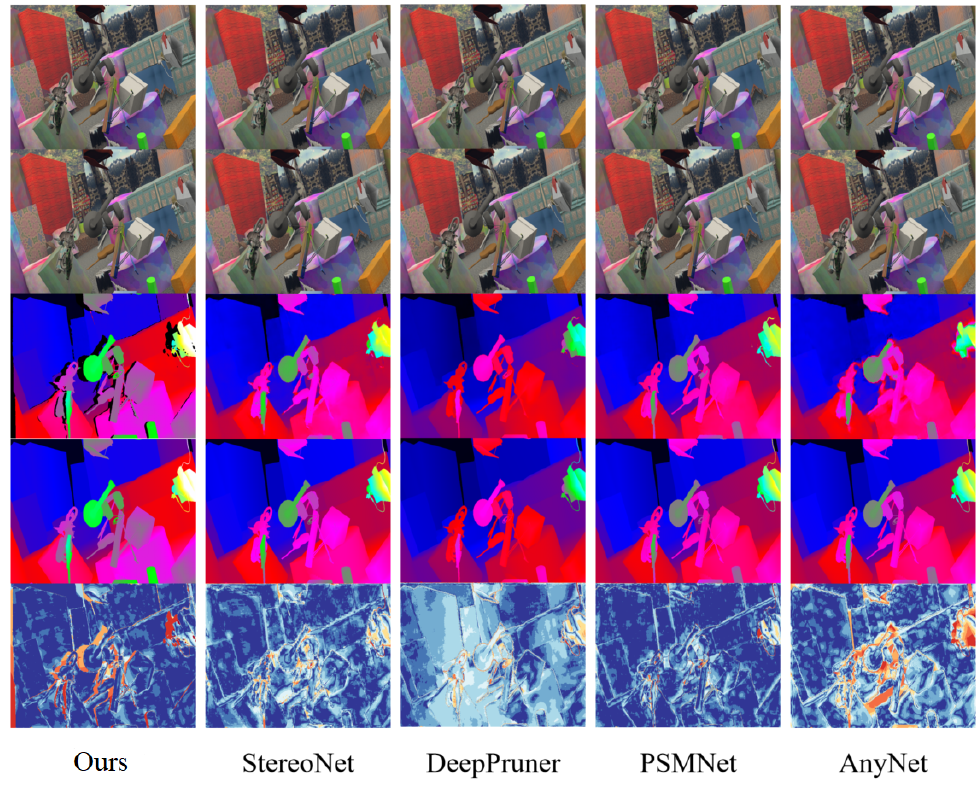
Figure 14. The comparison between out algorithm and other deep learning-based